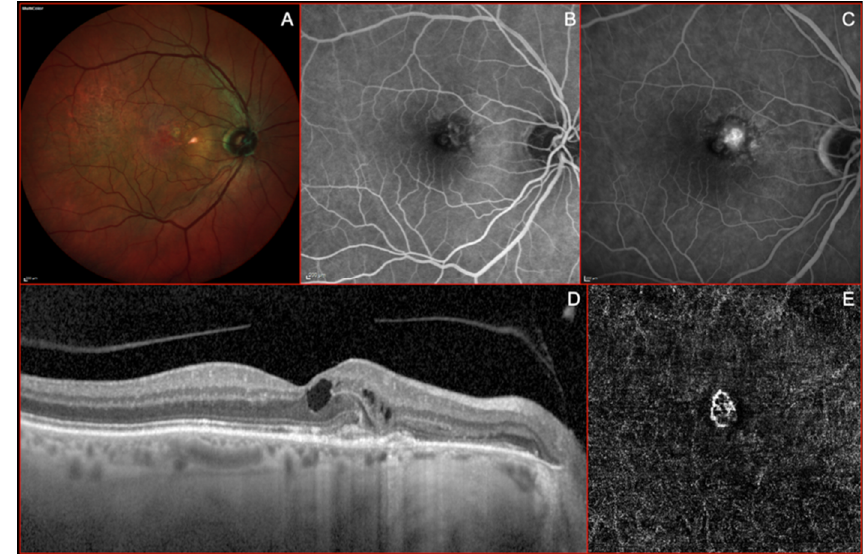
Figure 2. Imaging of a Type II or “classic” macular neovascularization (MNV). ( A ) Multicolor imaging showing some reddish lesion in macular area due to pigmentary changes associated with a yellowish area secondary to a focally increased reflectivity at the level of the outer retina. ( B ) Early venous phases of fluorescein angiography (FA) showing a well-defined neovascular network in the nasal side of macular area with a clear dye-leakage during the late frames ( C ). ( D ) Structural optical coherence tomography (OCT) showing a well-defined subretinal mild hyperreflective lesion, located nasally to the foveal depression, associated with intraretinal fluid accumulation (cystoid spaces). ( E ) A fine neovascular network is visible at the level of the outer retina on “en-face”